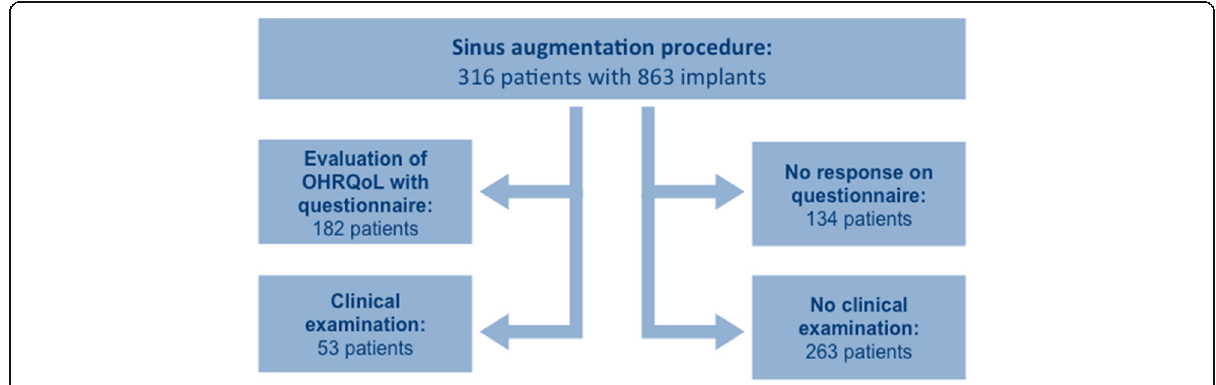
Fig. 1 Flow chart of patients included in the